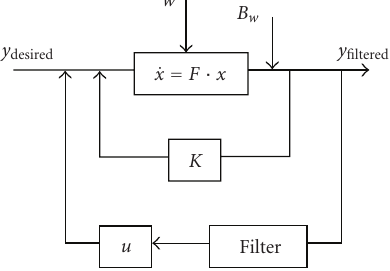
Figure 2: Schematic flow chart of the implemented dynamic system.